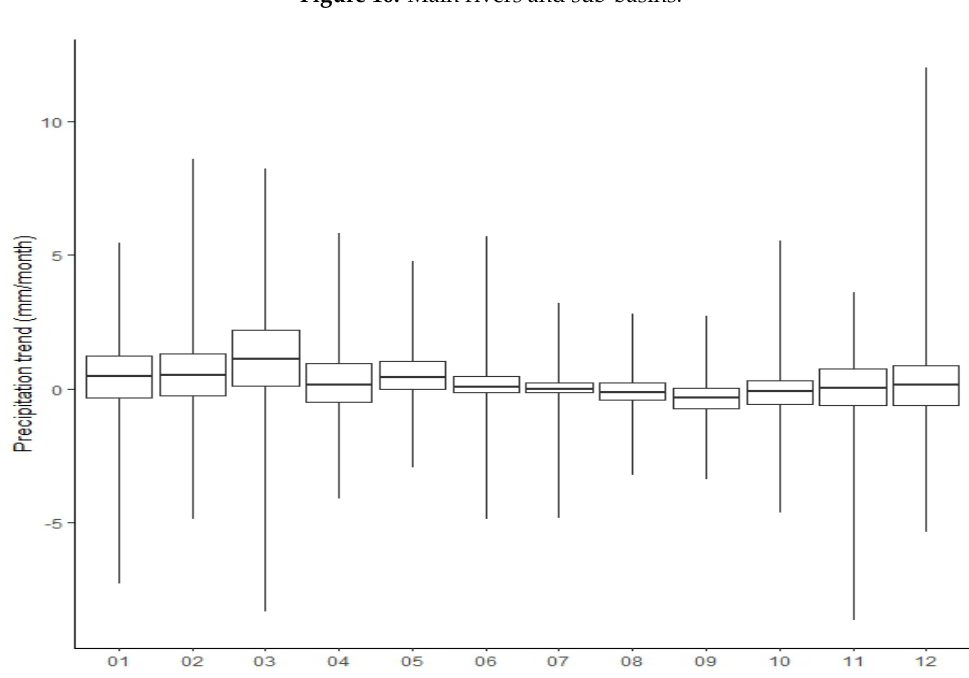
Figure 11. CHIRPS precipitation trend per month average.